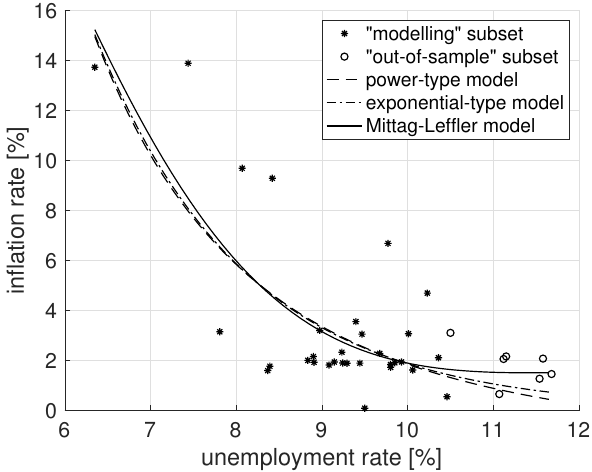
Figure 3. Fitting the French Phillips curve.